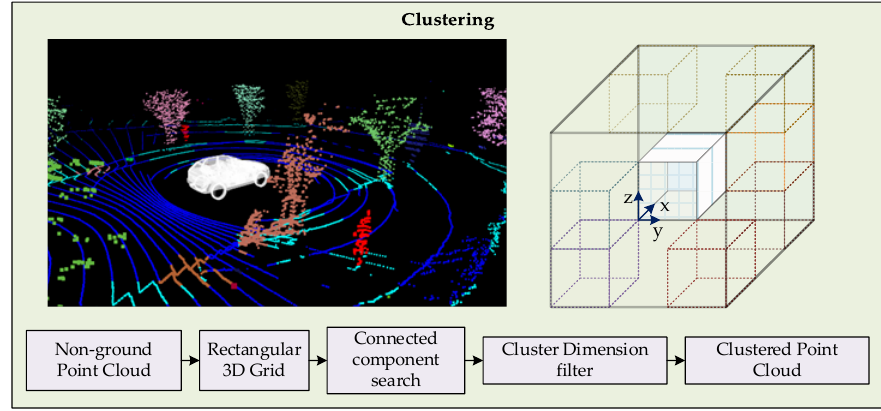
Figure 4. 3D rectangular grid-based clustering of point cloud, trackable objects in red color.